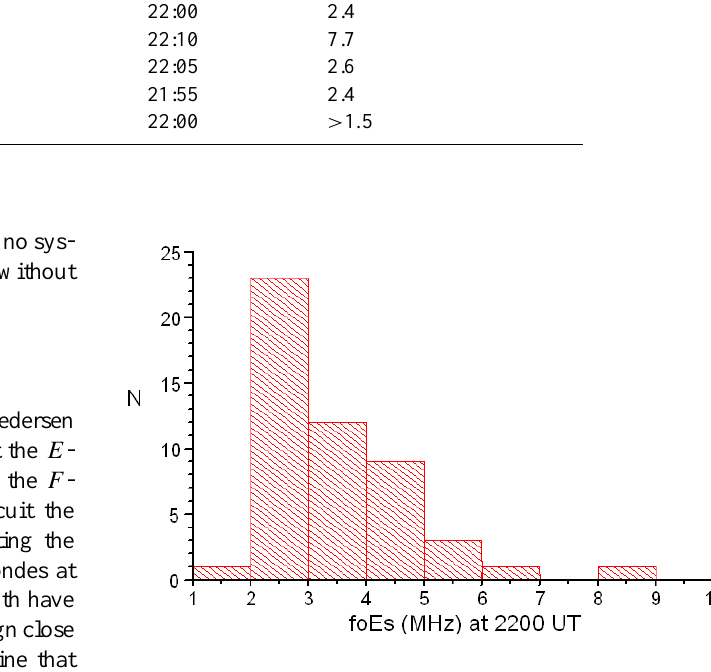
Figure 9. Distribution of foEs values at Boa Vista / Campo Grande at 2200 UT for ESF days at Cachimbo Fig. 9. Distribution of f oEs values at Boa Vista/Campo Grande at 22:00 UT for ESF days at